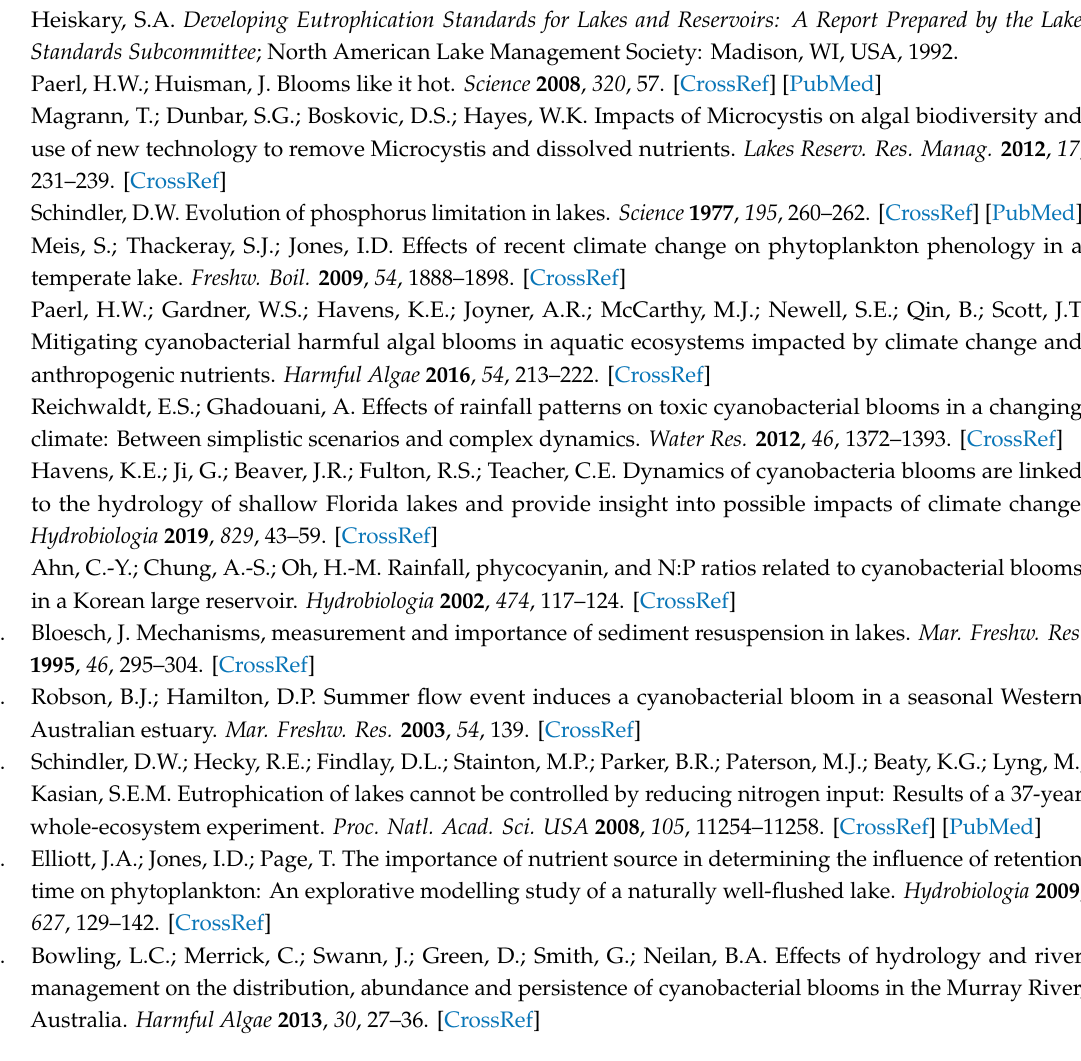
Table A4. Multiple regression models of remotely sensed chl-a data by site show a variety of significant linear relationships, ranging between 18% and 40% variance explained. Chl-a values were modeled using empirical and semi-empirical models